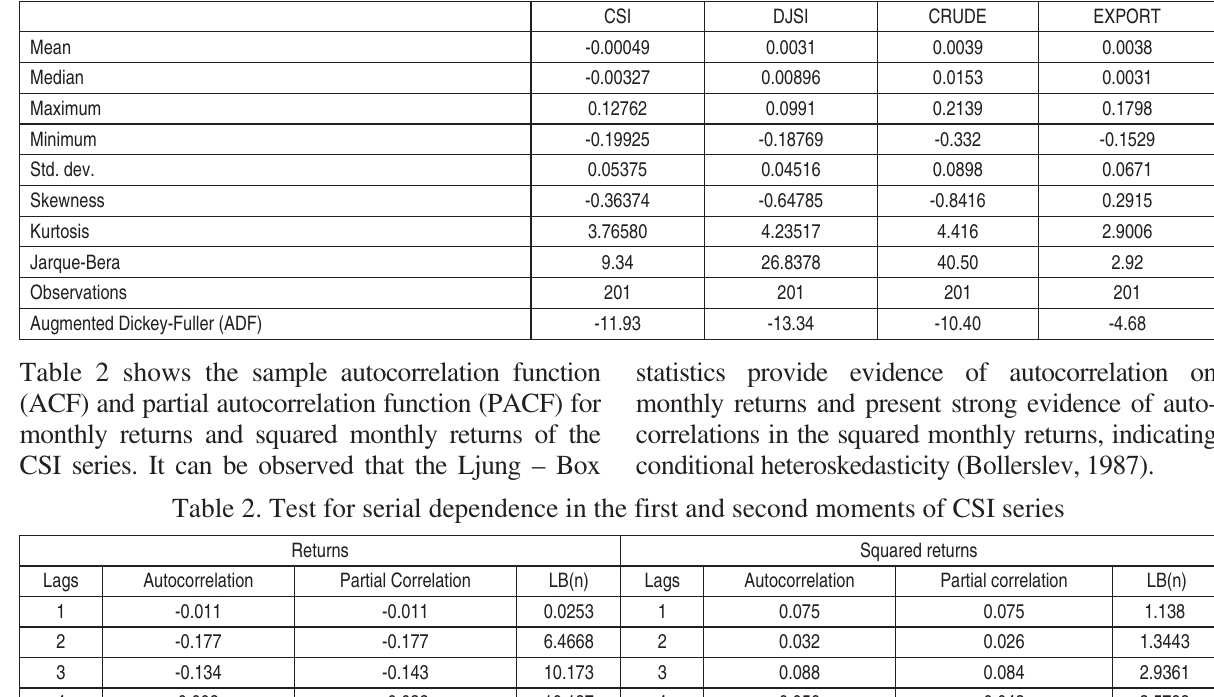
Table 1. Sample statistics